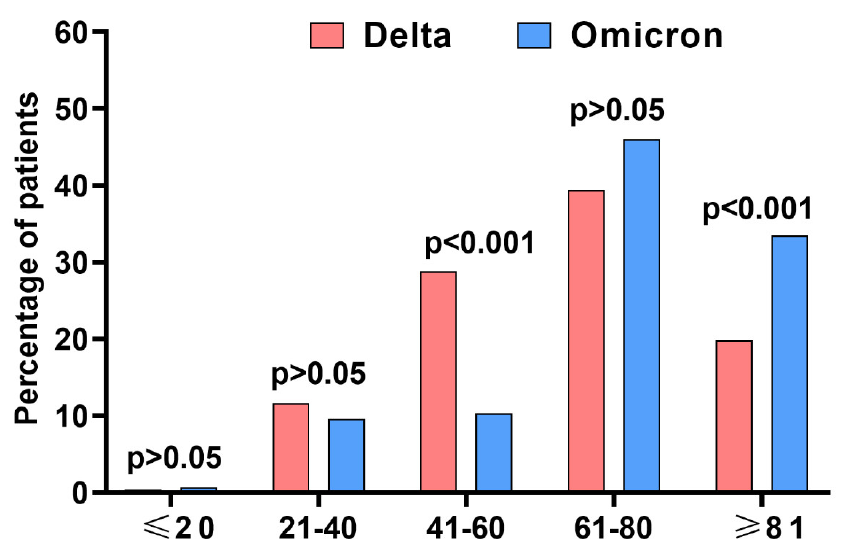
Figure 1. The age structure of patients treated with remdesivir during Delta wave ( n = 490) and Omicron-dominated period ( n = Omicron-dominated period ( n = 272).